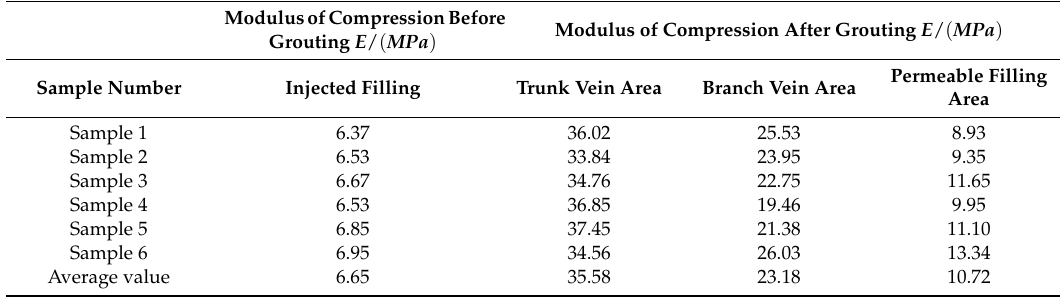
Table 2. Results of compressive strength test.